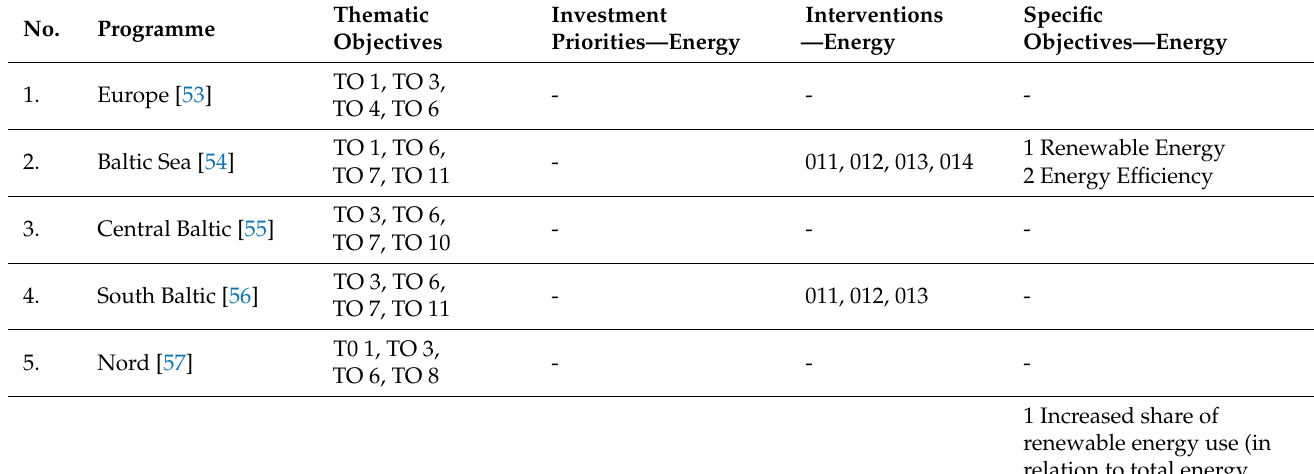
Table 2. Thematic Objectives, Investment Priorities related to energy, as well as Interventions and Specific Objectives in ETC programmes for BST in the period